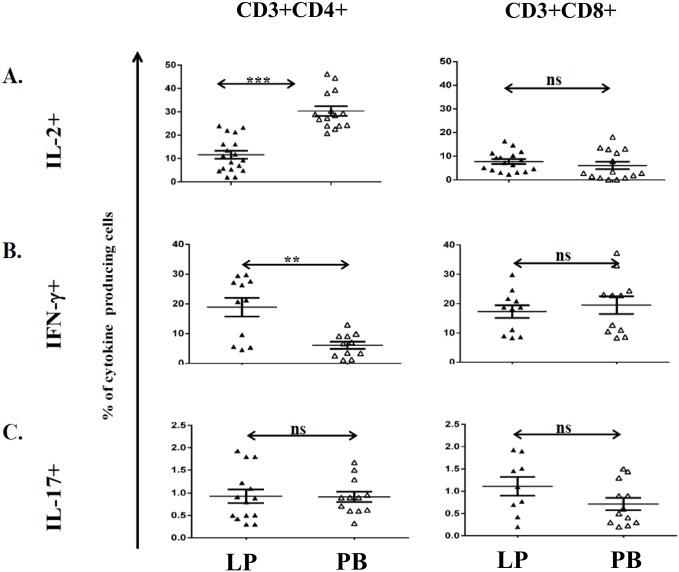
Cytokine production of T-cells in peripheral blood, LD, DBD and DCD livers.Hepatic mononuclear cells isolated from liver perfusate of living donors (LD) and matched PBMC were stimulated ex vivo and their cytokine production (n = 9 to 17) was assessed by intracellular staining. Frequency of IL-2 (A), IFN-γ (B) and IL-17 producing CD4 (left) and CD8 (right) T-cells (C). ** p<0.01, *** p<0.001. Furthermore, HMC isolated from DBD, DCD or LD livers have been stimulated ex vivo and cytokine production assessed by intracellular staining. Gating strategy determined using unstimulated cells. Numbers indicate percentage of cells detected; (D-F) Cytokine production of HMC isolated from indicated liver donors. Frequency of CD4 or CD8 T-cells expressing IL-2 (D), IFN-γ, E) and IL-17 (F). Statistical analysis: Mann Whitney U or Kruskal Wallis test was applied, ns = non-significant, **p<0.01, ***p<0.001.